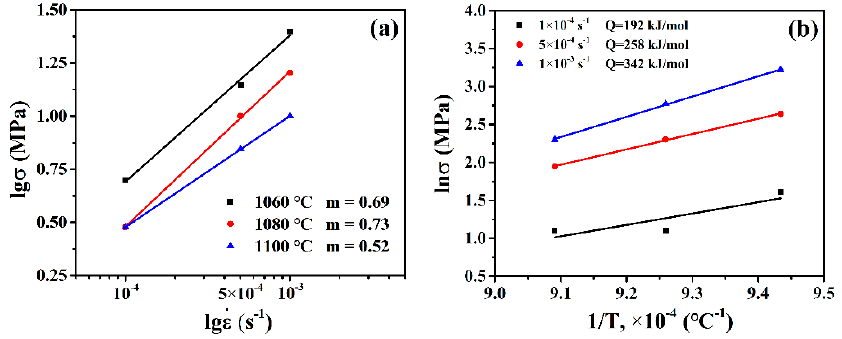
Figure 6. ( a ) Flow stress as a function of strain rate at various temperatures and ( b ) ln s as a function of reciprocal temperature.